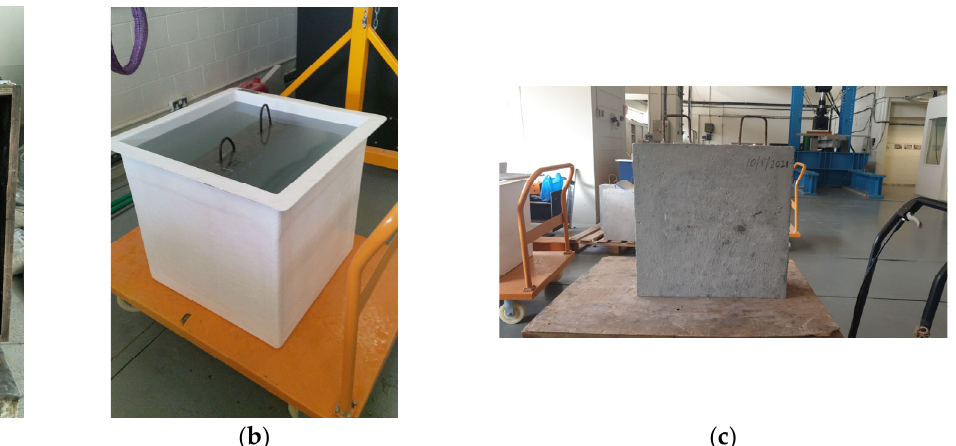
Figure 2. Location, size, and depth of the embedded subsurface defects in the concrete specimen. The schematic drawing is to scale.